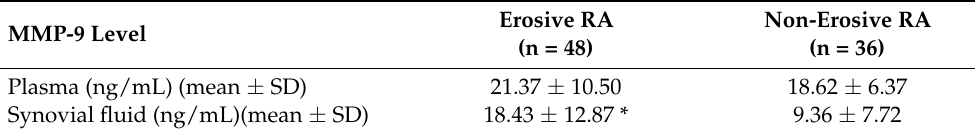
Table 2. MMP-9 level (ng/mL) in plasma and synovial fluid of patients with erosive and non- erosive RA.